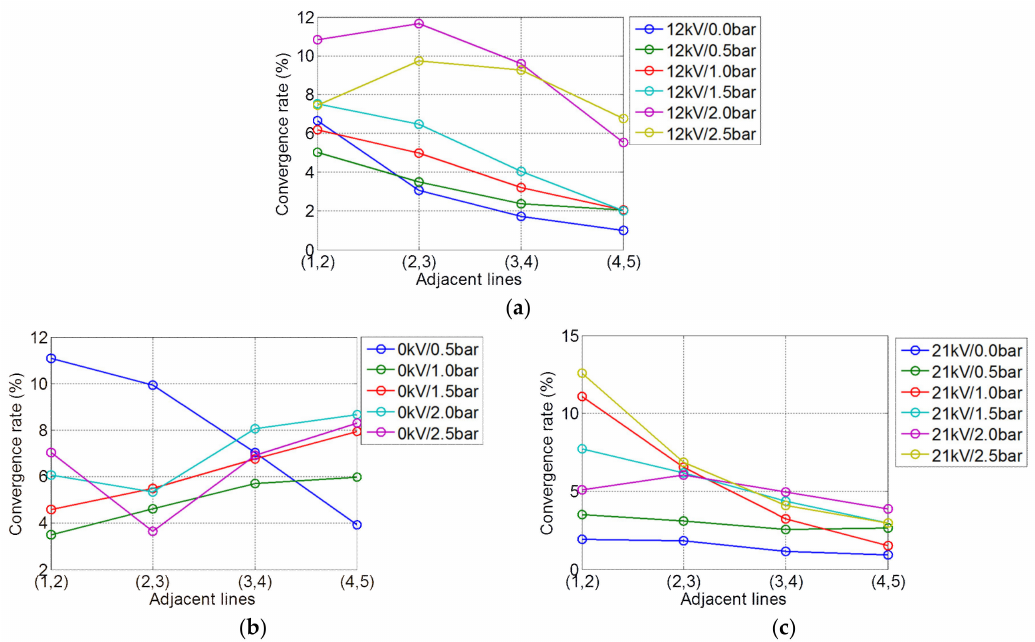
Figure 9. Comparison of the profile convergence rate accroding to the process conditions. ( a ) Profile convergence was degraded by applying the pneumatic pressure at the electricfield of 12 kV; ( b ) most conditions without the electric field were not converged; ( c ) high electric field can help to enhance the profile convergence at high pneumatic pressures.